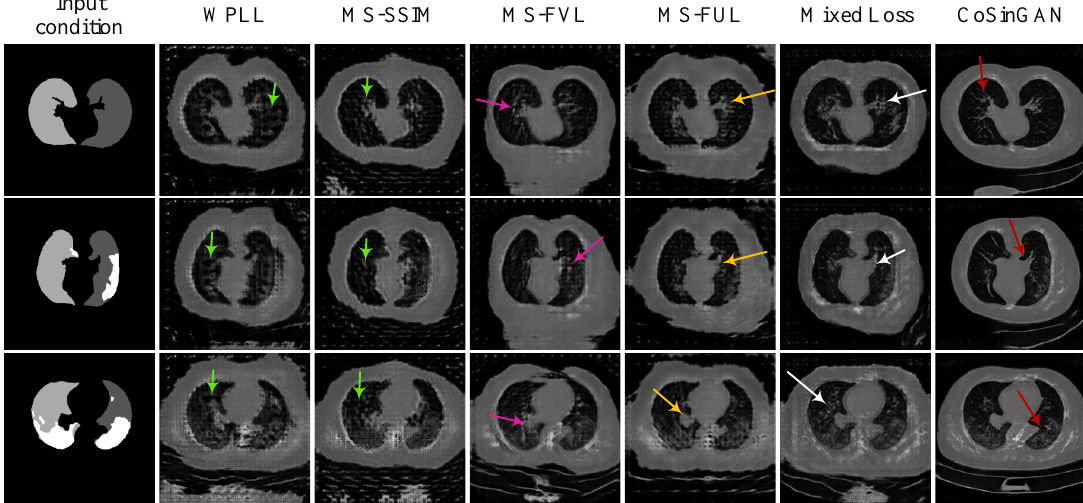
Figure 8. Comparison of synthetic radiological images with image size of 256 × 256 from multiple CoSinGANs trained with different reconstruction loss. Arrows are used to highlight the differences. The white and gray (e.g., light gray and dark gray) in condition masks represent the infected regions and lungs,